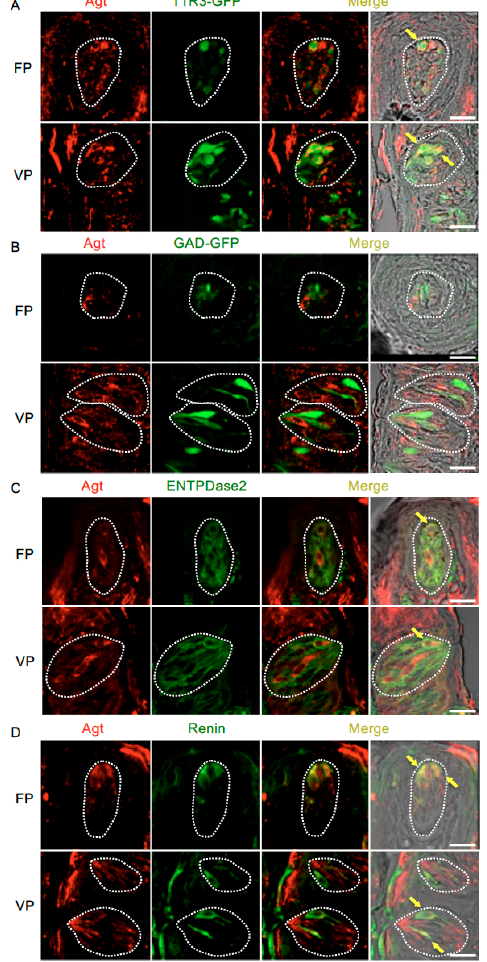
Figure 4. Co-expression of angiotensinogen (Agt) with taste receptor type 1 member 3 (T1R3), glutamate decarboxylase 67 (GAD), nucleoside triphosphate diphosphohydrolase-2 (ENTPDase2) and renin